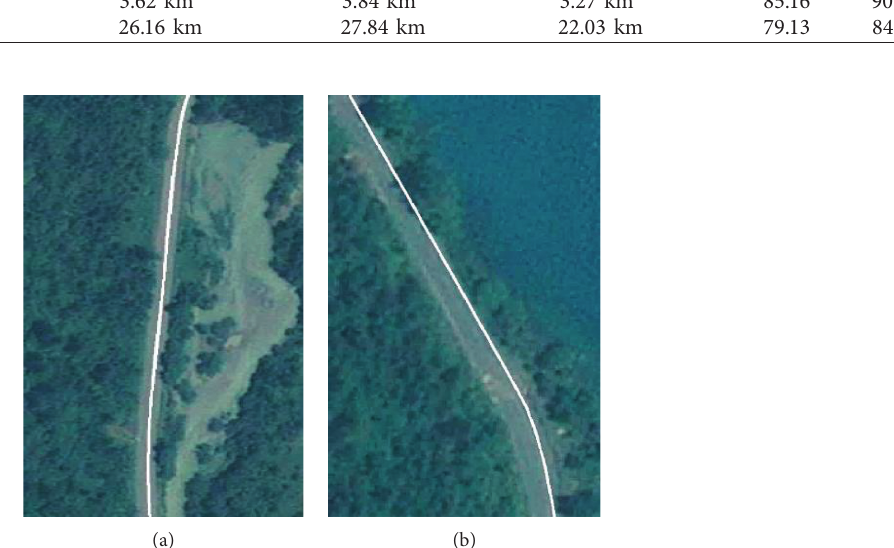
Figure 9: Road data deviation in the images. (a) Road data matches its position in image; (b) road data drifts from its position in